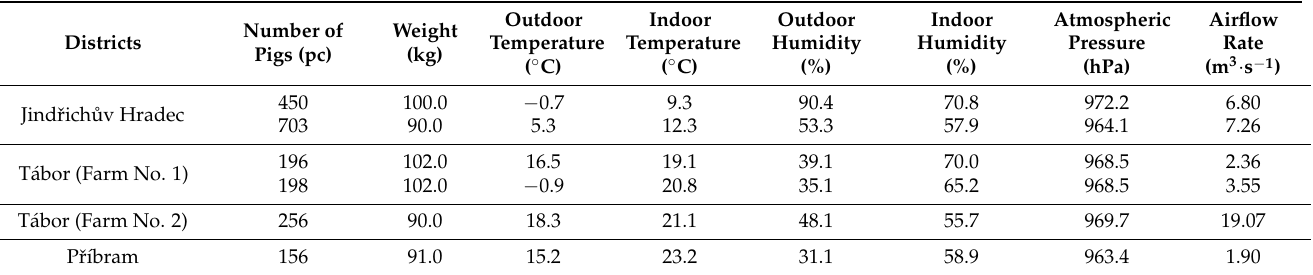
Table 3. Climatic and microclimatic conditions during the first approach monitoring.